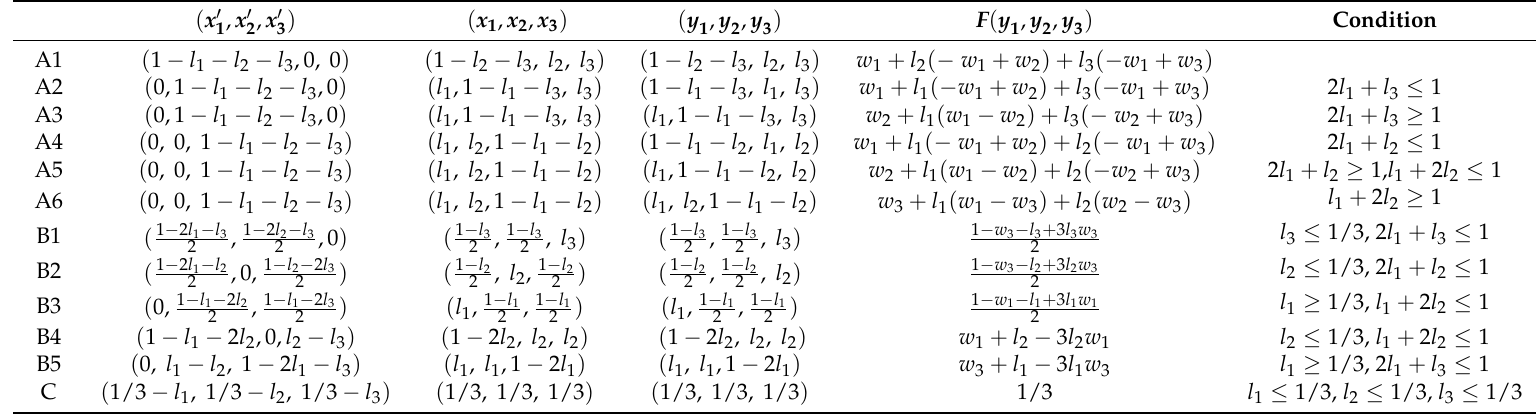
) , ( x ) and ( y ) , F ( y ) and condition for 3COWAL with l , x (cid:48) , x (cid:48) 1 , x 2 , x 3 1 , y 2 , y 3 1 , y 2 , y 3 2 3 1